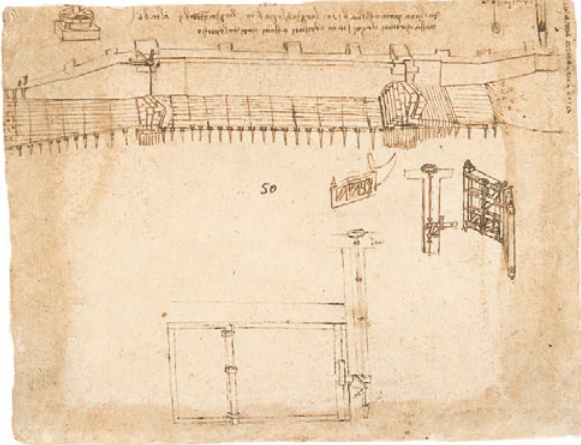
Figure 13. C.A., fol. 935r: Chamber, or navigation basin, with the kind of locks called “porte vinciane”.